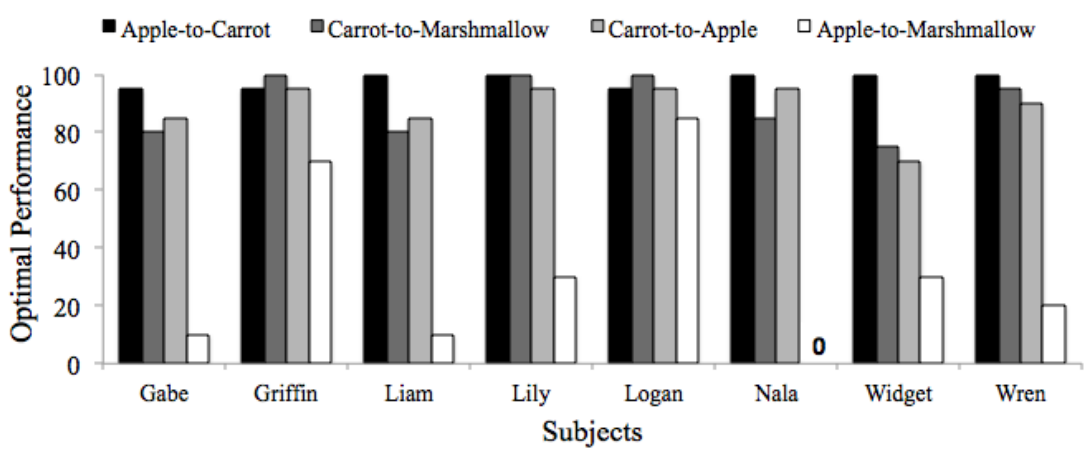
Figure 4. Exchange test performance across the four trial types in Experiment 1. Performance was collapsed across the two accumulation conditions (free and forced